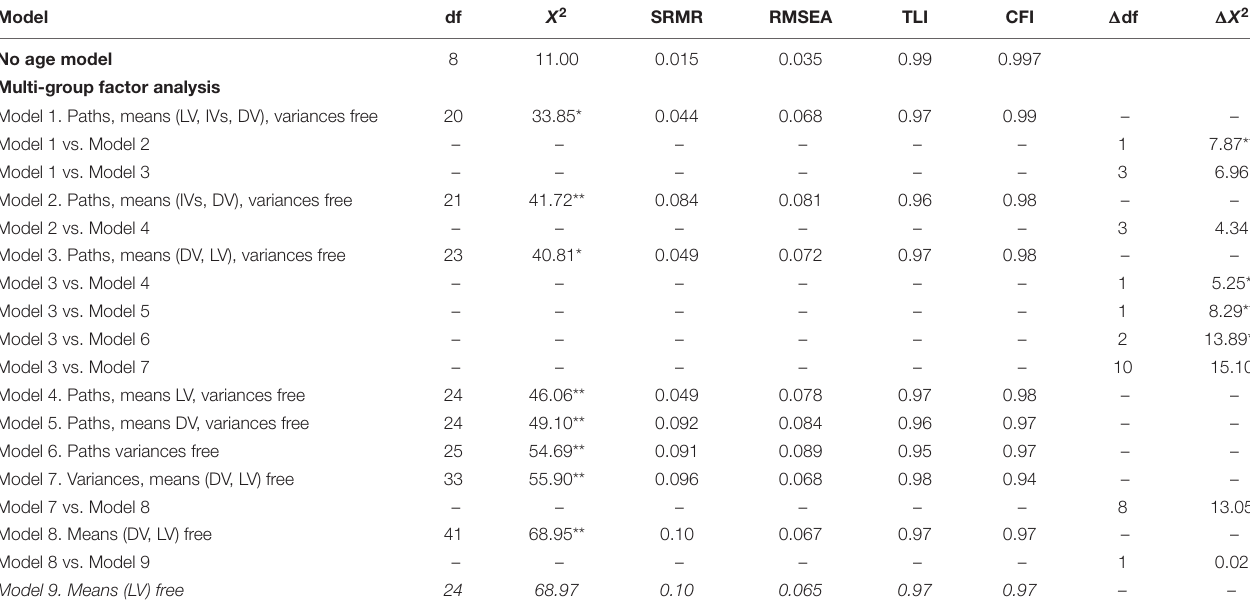
TABLE 3 | Results of structural equation models for depression.